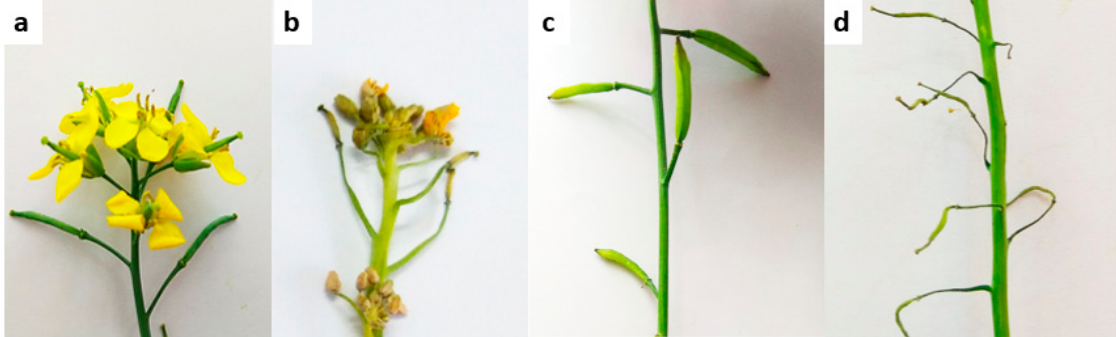
Figure 4. Effect of salinity on the reproductive organs at 7 d after treatment. ( a ) Inflorescence under control conditions; ( b ) inflorescence under 100 mM NaCl; ( c ) siliquae at control conditions; and ( d ) siliquae under 100 mM NaCl.